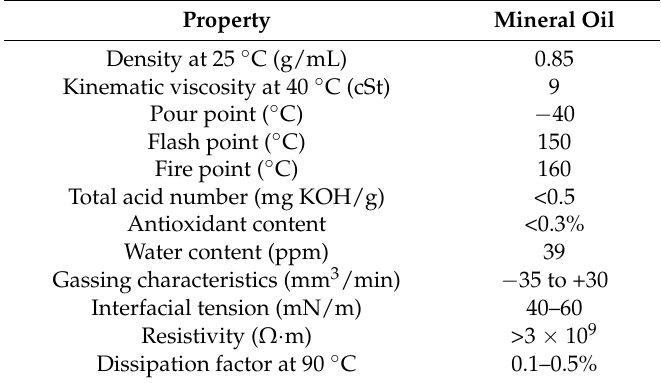
Table 1. Physicochemical properties of the mineral